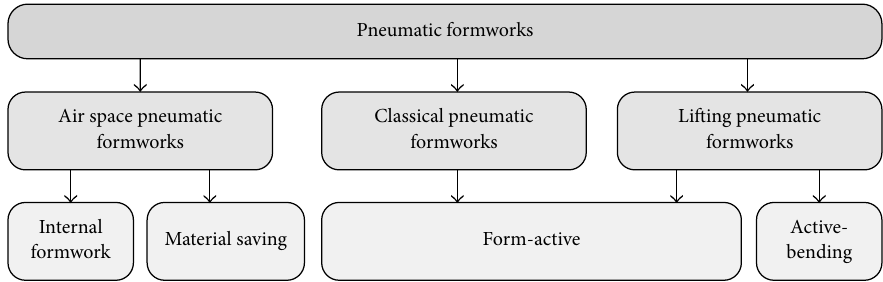
Figure 17: Categorization of the different pneumatic formwork systems.